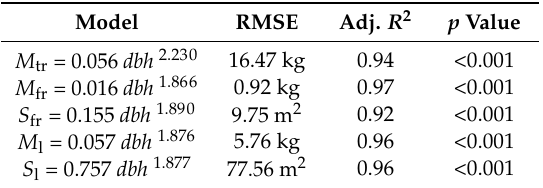
Table 3. Model parameters and performance criteria of biomass and surface area ( n = 17).